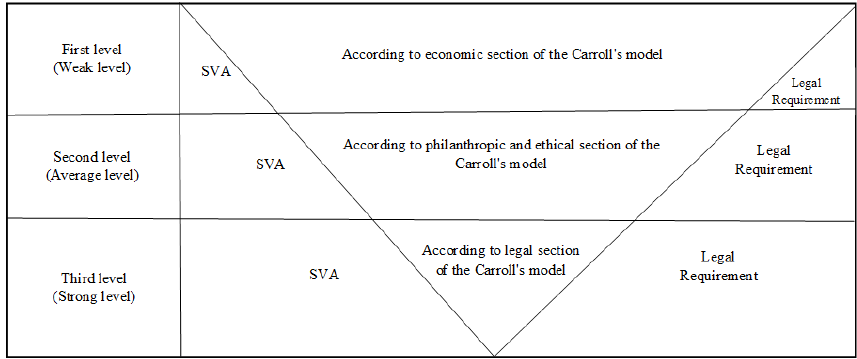
Figure (2): The corporate social responsibility model by Social Value